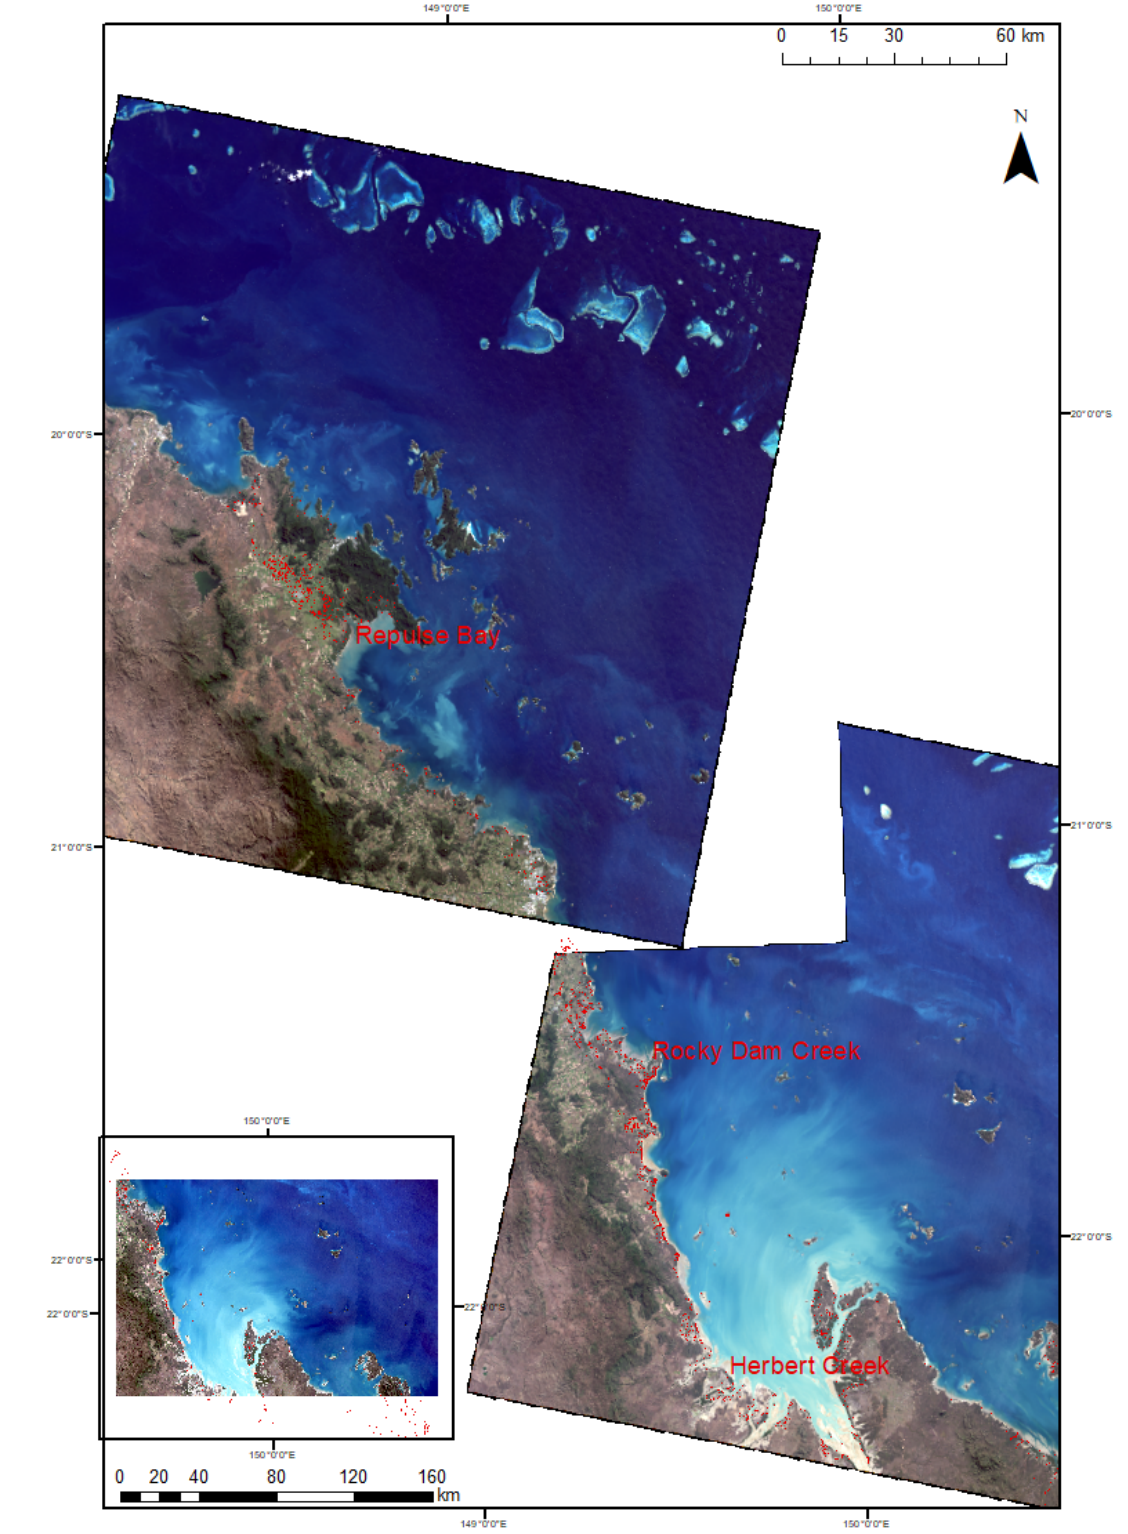
Figure 3. Landsat Operational Land Imager (OLI) true-colour mosaic (images captured 16 July 2020 and 9 August 2020) overlaid with the change map of mangrove forest extent (decline) in red from the Random Forest classification and showing the three sites input to GEE for time series construction and subsequent phenology analysis: northern site, Repulse Bay; mid-section, Rocky Dam Creek/Cape Palmerston National Park; and southern site, Herbert Creek, study region is Bowen to Shoalwater and Corio Bays Area Ramsar